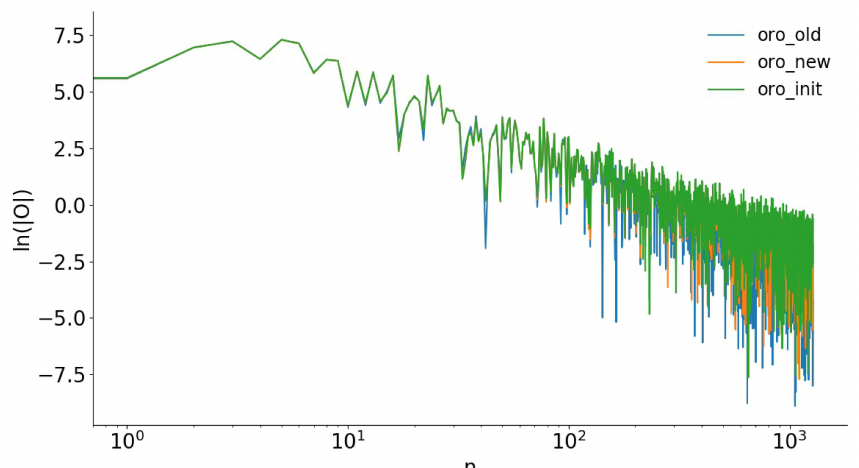
Figure 3. Natural logarithm of the moduli of the first 1000 orographic spectral coefficients. Model’s original orography (oro_old), orography after processing (oro_new), and the initial orography before processing